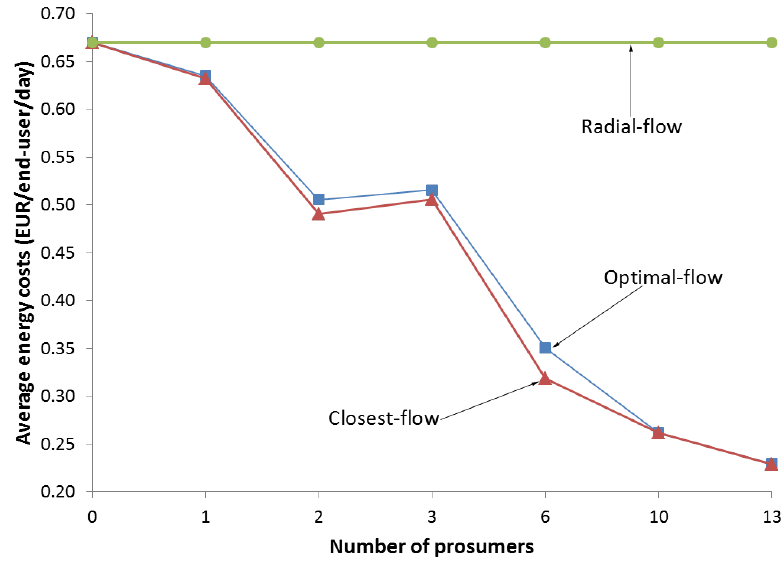
Figure 7. Average energy costs per end-user per